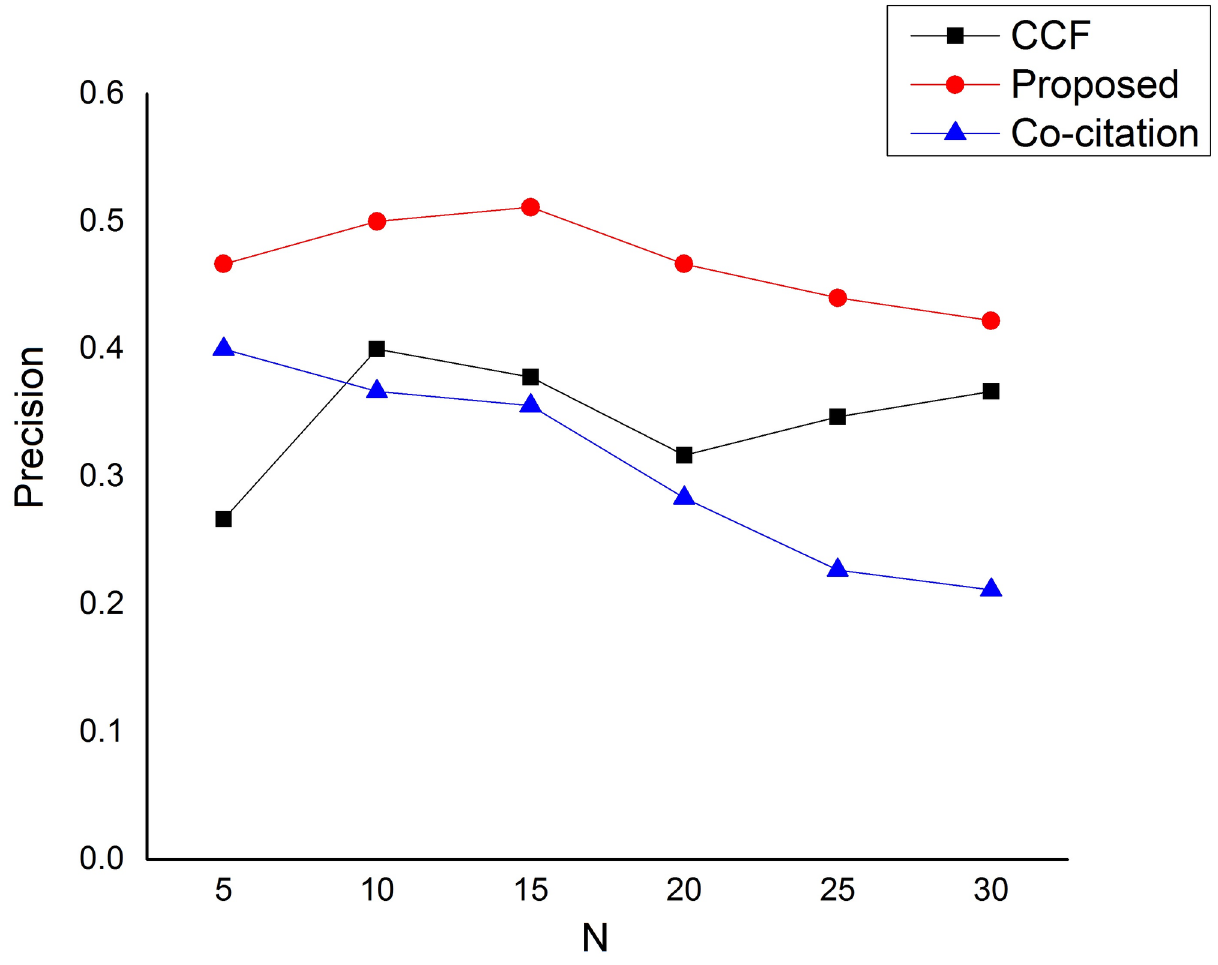
Fig 2. Precision performance on the